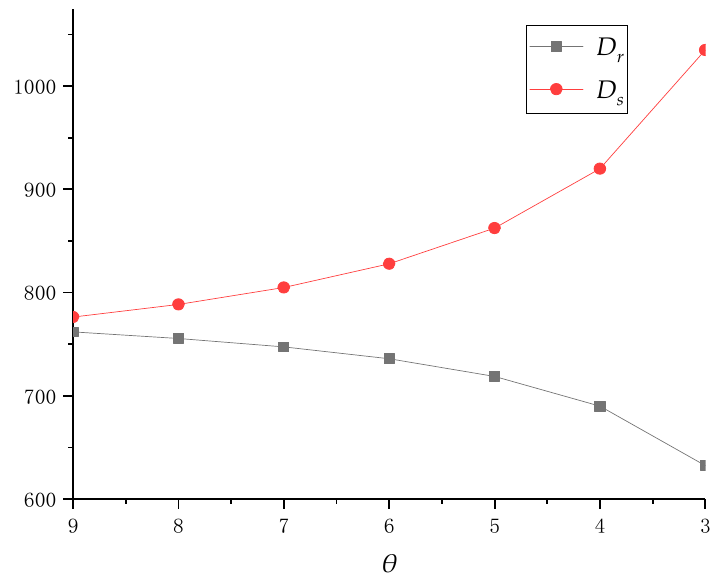
Figure 4. The collective quantity changes in dual channels with different μ when θ = 0.4.